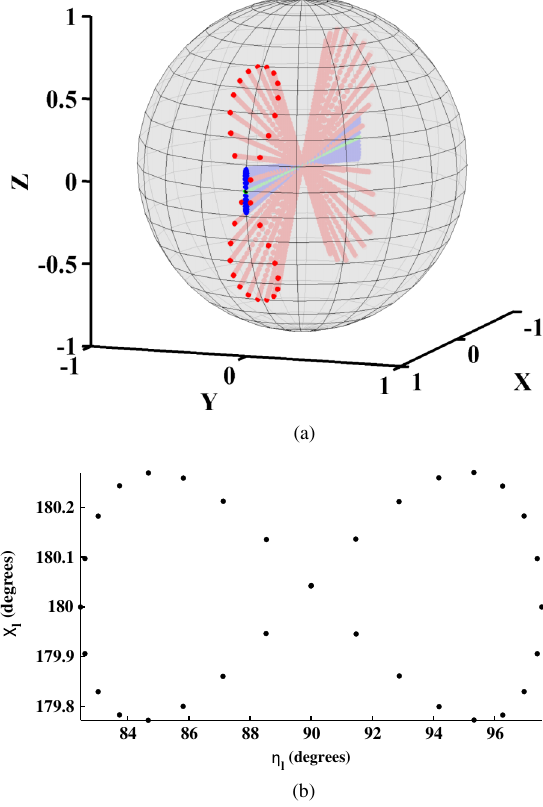
FIG. 18. (a) Phasor representation of the recirculating laser beam. In red the polarization after the reflection on the first mirror of the MPS, in blue the polarization at the IP, in black the polarization after the collimating parabolic mirror, and in green (over the black dots lying to the line of equation y ¼ z ¼ 0 ) the polarization after the second mirror of the MPS. (b) Angular distribution of the azimuthal η l and polar χ l angles at the IP corresponding to the blue circles of Fig. (a).